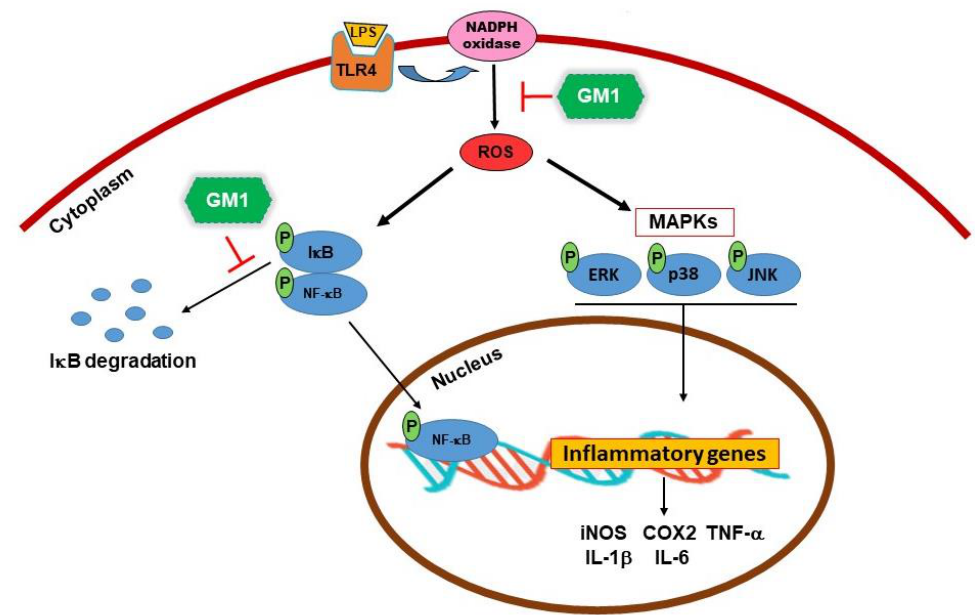
Figure 11. Schematic of the anti-inflammatory mechanism of GM1 ganglioside. GM1 inhibited the proinflammatory responses in LPS-treated RAW 264.7 cells by suppressing NADPH oxidase-mediated ROS production and subsequently inhibiting NF- κ B and MAPK signaling pathways.